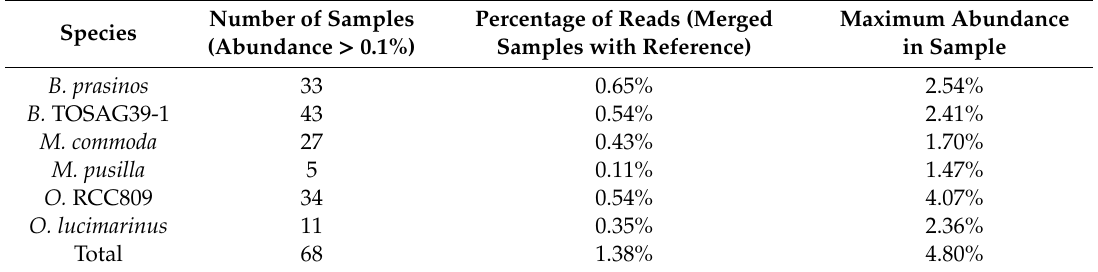
Table 2. Mamiellales repartition and abundances among Tara Oceans samples.